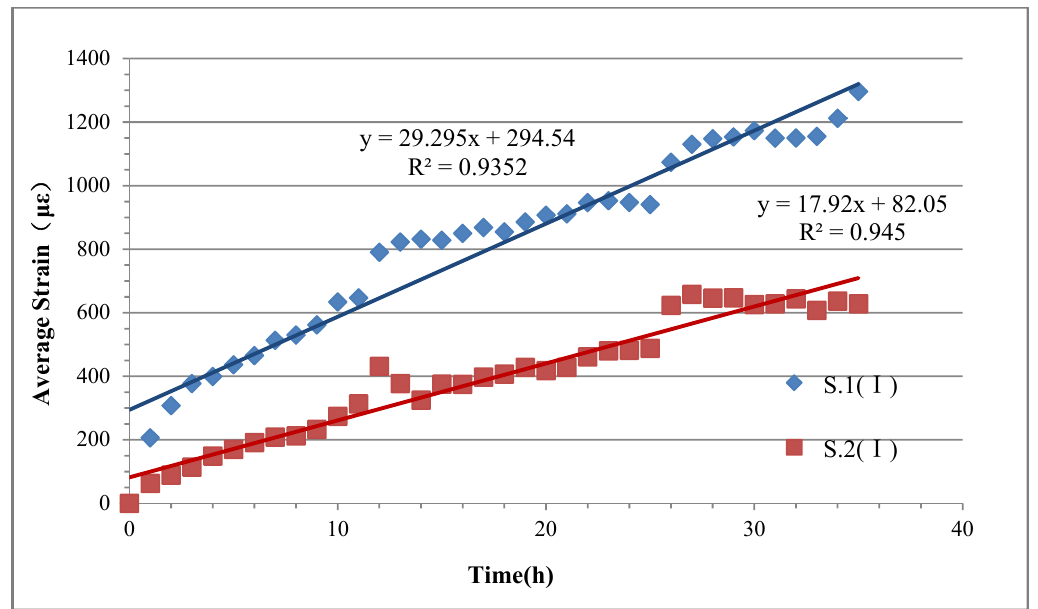
Figure 14. The average strains of sensor S.1 (I) and S.2